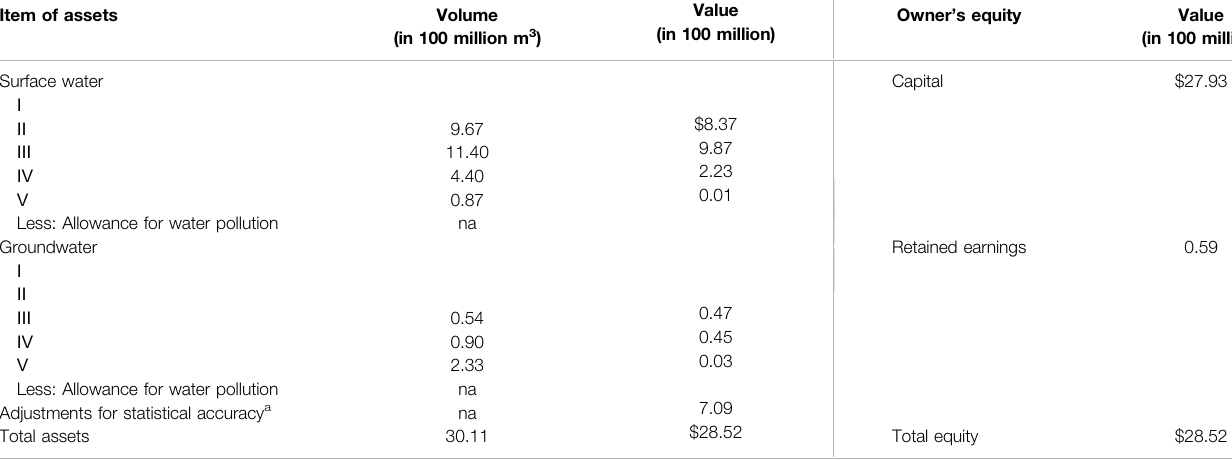
TABLE 6 | Wuhan ’ s water resource balance sheet in